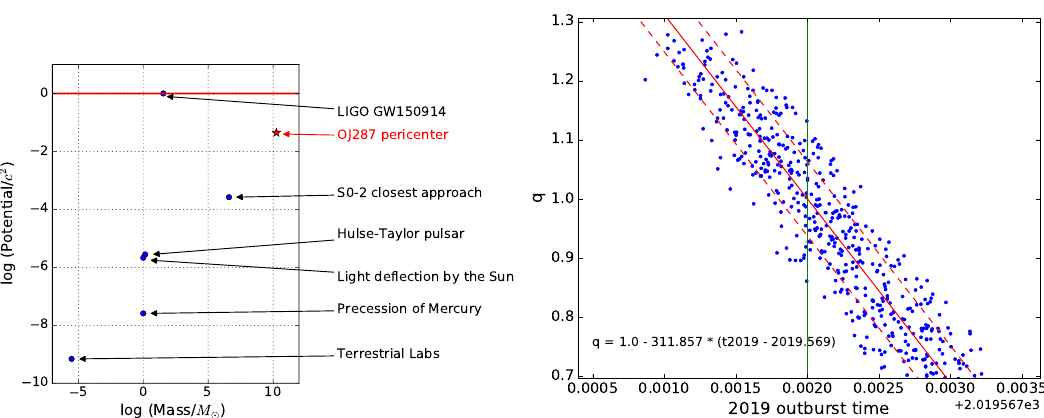
Figure 4. The left panel plots the dimensionless gravitational potential against the gravitating mass in solar mass units for systems used to test Einstein’s GR; The unique position of OJ 287 is clearly visible. The right panel shows the correlation between the value of the q parameter and the starting time of 2019 outburst where each point represents a possible solution of the binary in OJ 287. The solid red line shows our fit to the observed correlation and the dashed red lines indicate its 1 σ deviation (the fit equation is given in the lower-left corner of the plot). The green vertical line represents the expected outburst starting time from the model [9]. ©AAS